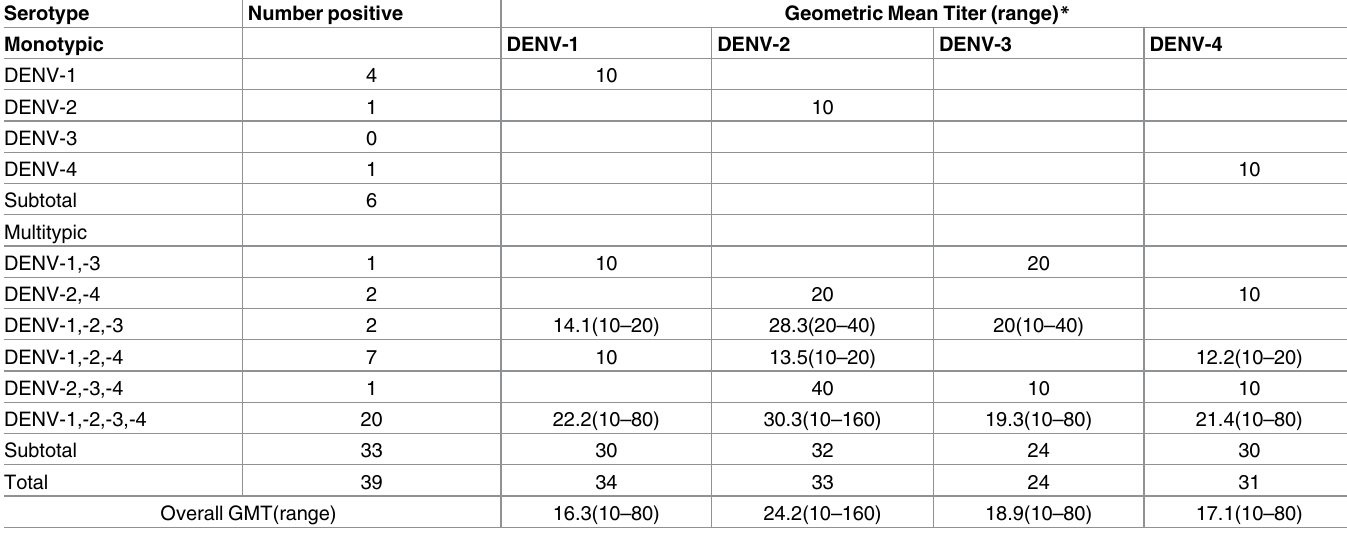
Table 4. Dengue neutralizing antibody responses, Papua New